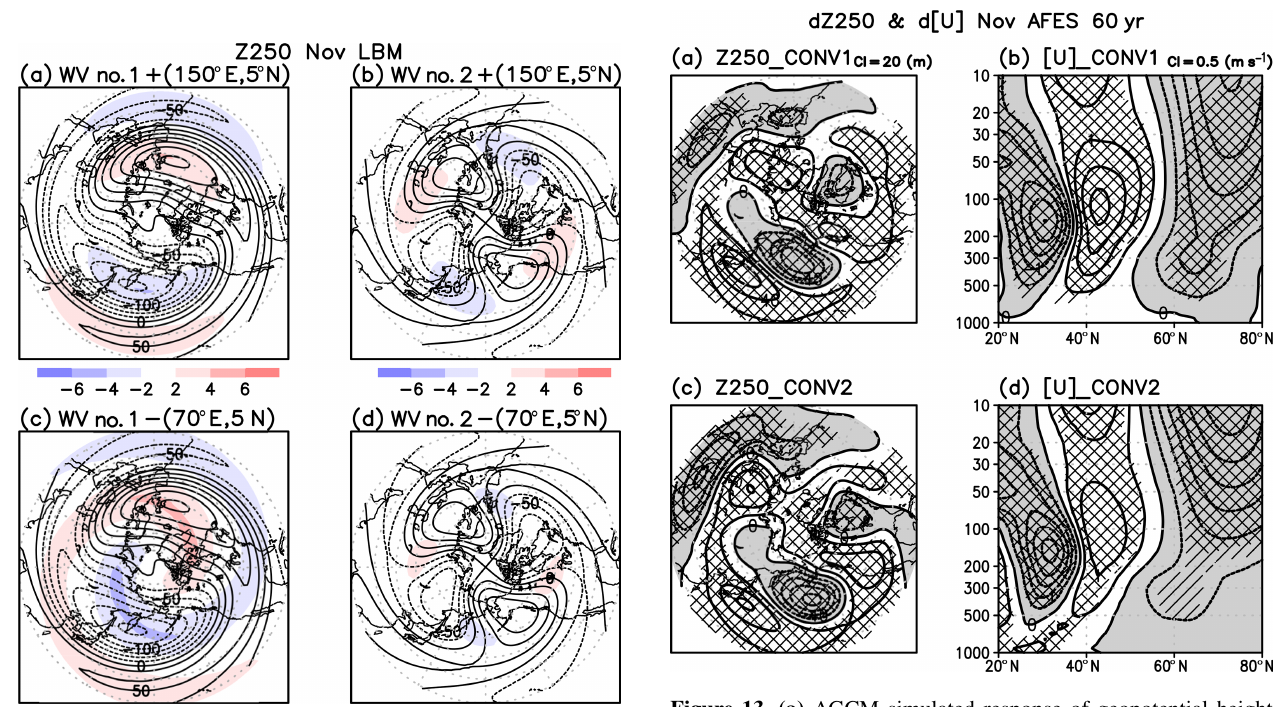
Figure 11. Wave-1 and -2 components of linear responses of geopo- tential height at 250hPa (Z250) simulated by LBM with the Novem- ber background field. (a) Z250 wave-1 response at day 30 to the adi- abatic heating centered at 5 ◦ N, 150 ◦ E (shade). Contour shows the corresponding November climatological wave-1 field. Contour in- terval is 25m. (b) Same as panel (a) but for wavenumber 2. (c) Same as panel (a) but for the adiabatic cooling centered at 5 ◦ N, 70 ◦ E. (d) Same as panel (c) but for wavenumber 2.